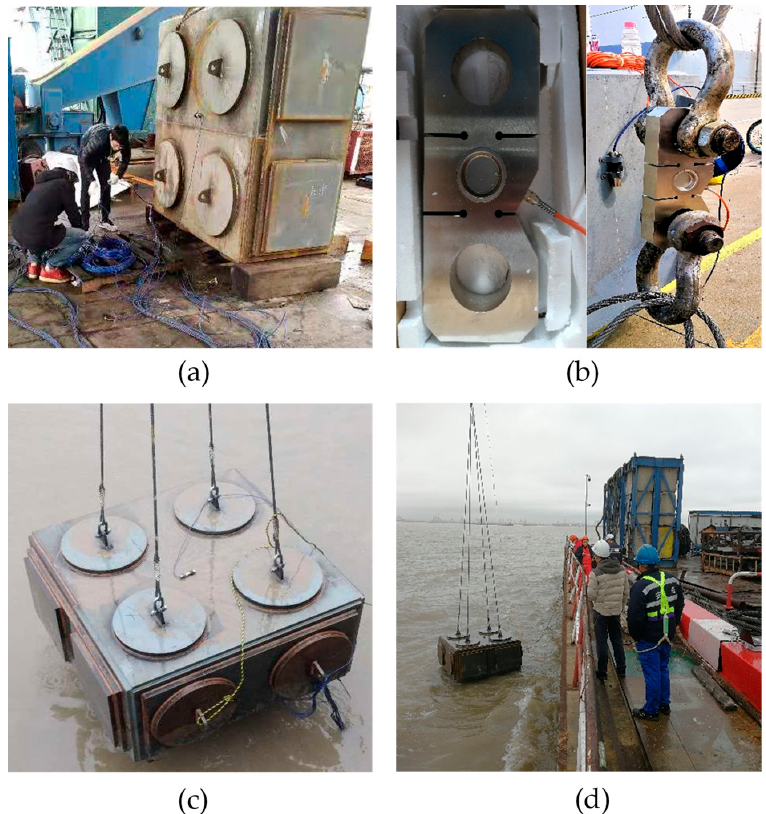
Figure 4. Photographs taken during the test: ( a ) numbering of the transducers and calibration of their initial values; ( b ) dynamometer used in the test; ( c ) lowering of the model to start the test; ( d ) test site.